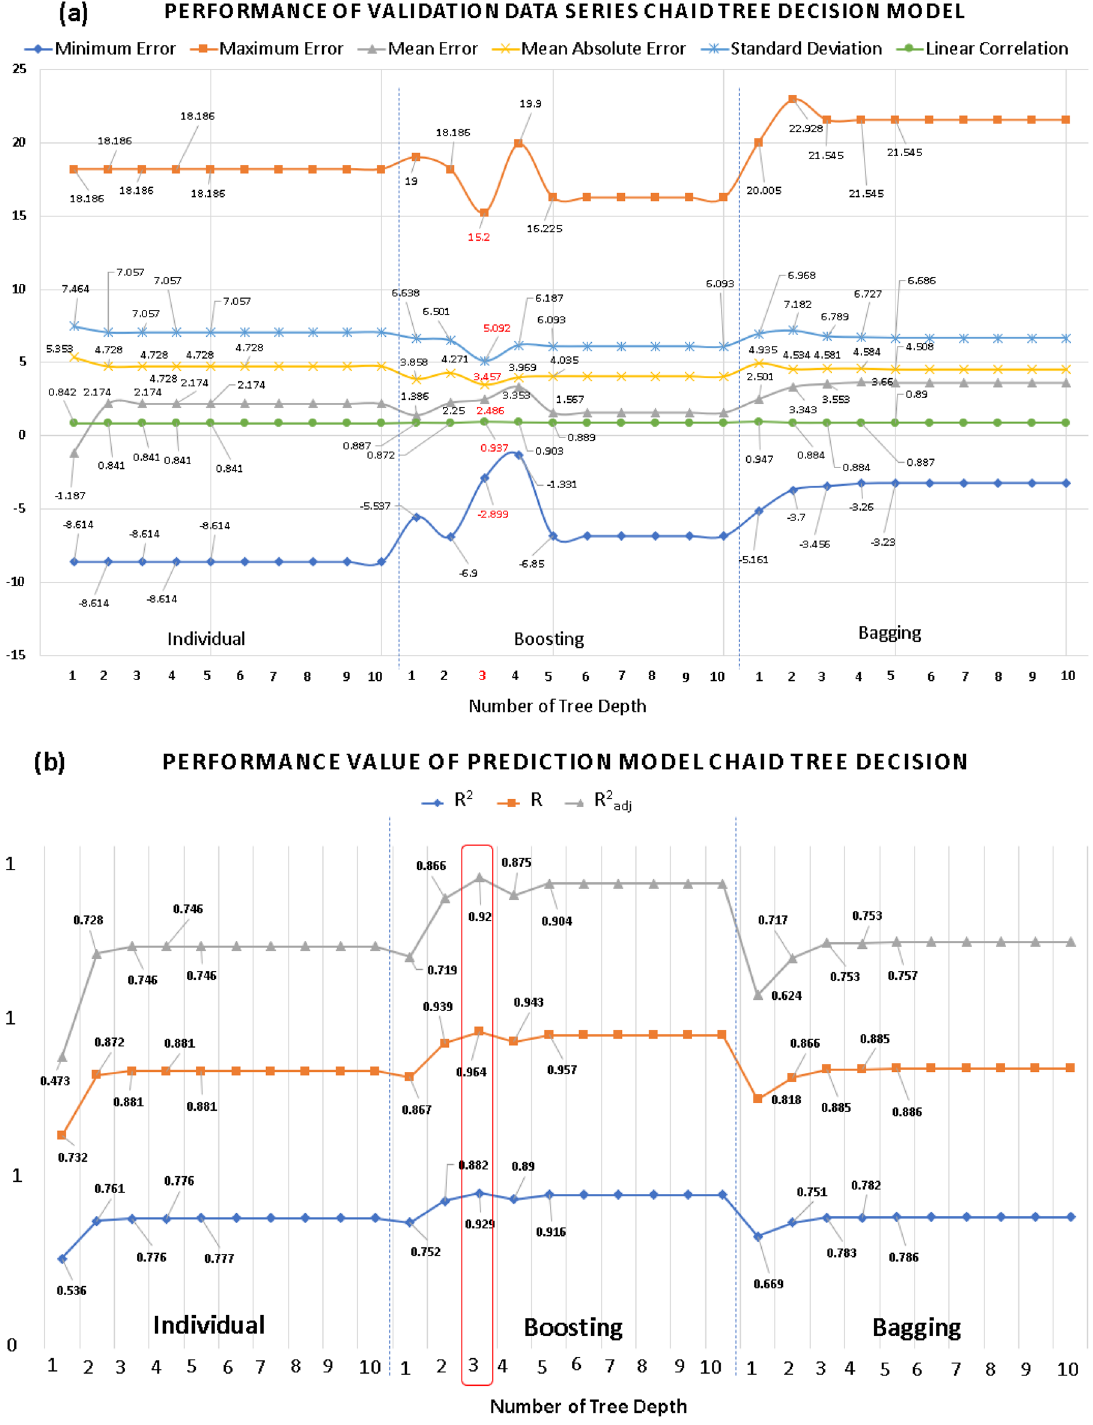
Figure 11. Performance evaluation and comparison ( a ) validation data ( b ) prediction models of the single, boosting and bagging models of CHAID decision tree for modeling i corr of carbon steel in soil with variations in the number of tree